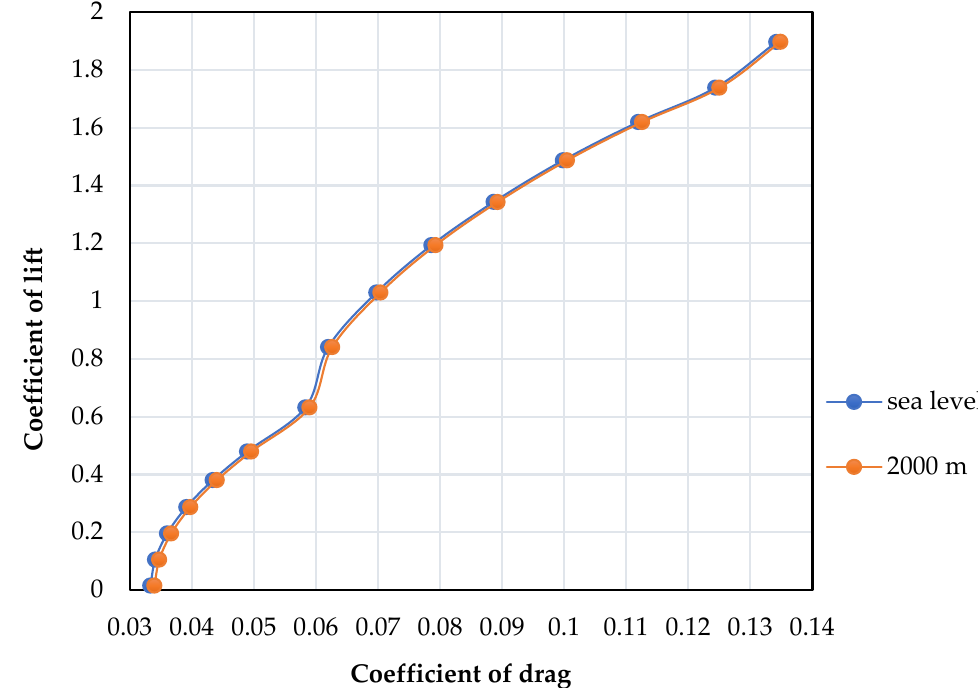
Figure 23. Coefficient of lift versus coefficient of drag.